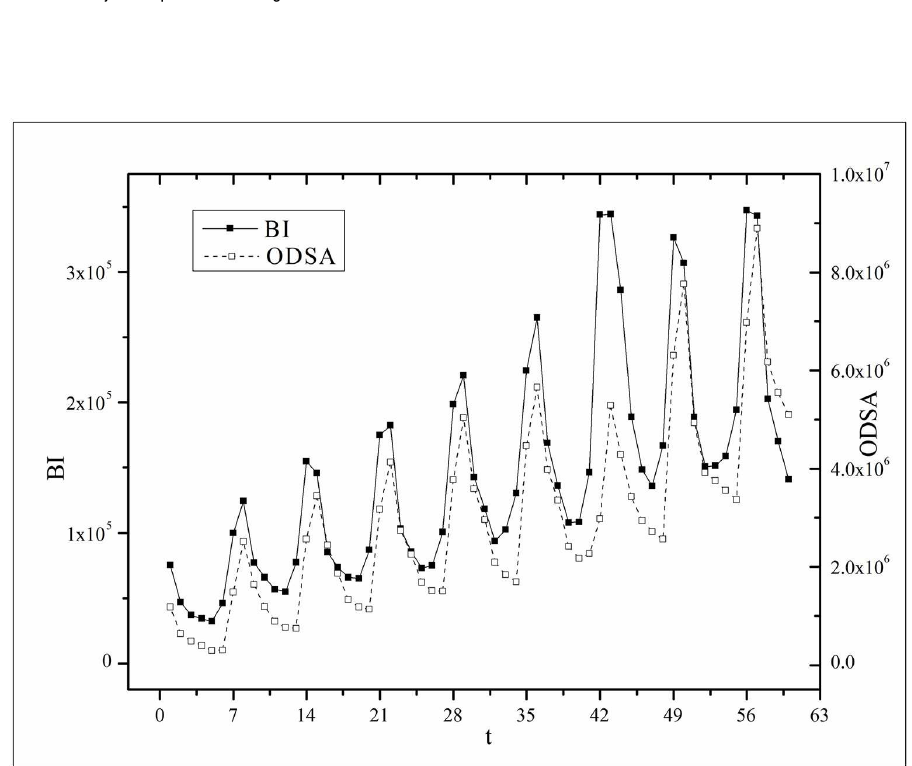
Fig 9. Correlation analysis of the Masters